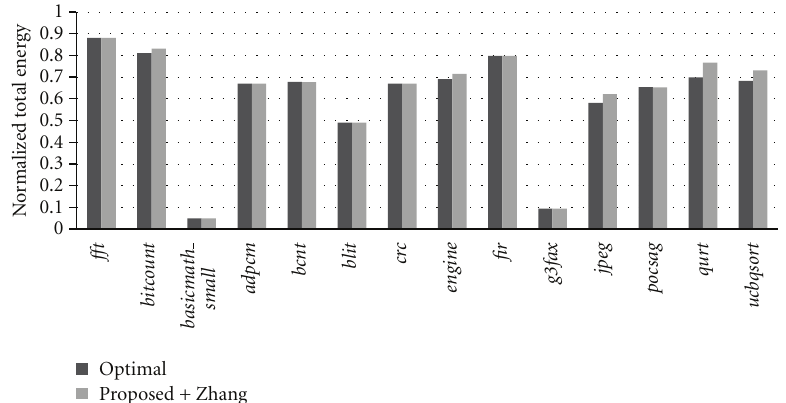
Figure 11: Total Energy consumption normalized to the base cache configuration for Zhang Heuristic and Optimal values.